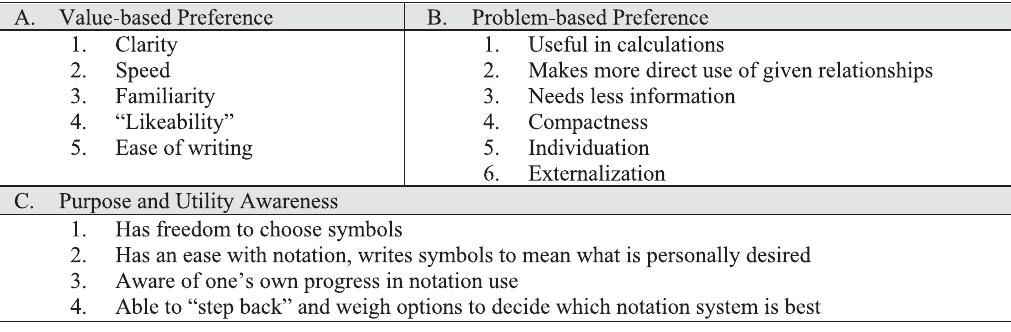
FIG. 1. The list of MRC categories and codes that resulted from our data